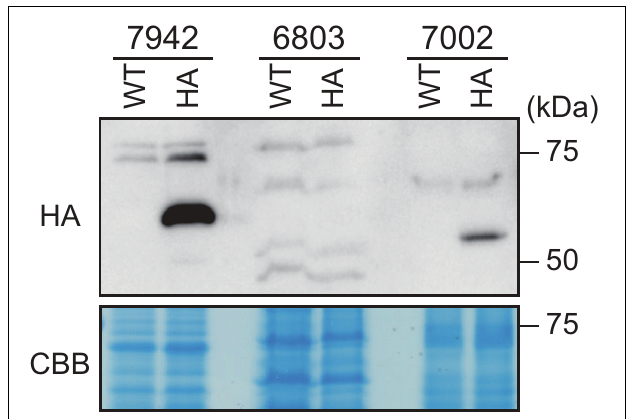
FIGURE 7 | Comparison of DnaA expression levels in Synechococcus elongatus , Synechocystis sp. PCC 6803, and Synechococcus sp. PCC 7002. DNAs encoding HA-tagged DnaA of S . elongatus (7942), Synechocystis sp. PCC 6803 (6803), or Synechococcus sp. PCC 7002 (7002) were integrated into the respective chromosomal dnaA locus (Ohbayashi et al., 2019; Supplementary Figure S3B,C ). HA-DnaA expression was driven by the endogenous dnaA promoter. Exponentially growing transformants were inoculated into fresh inorganic medium and cultured for 6 h with illumination (70 µ mol m - 2 s - 1 ). The same amounts (80 µ g) of proteins extracted from the respective cultures were subjected to immunoblotting using an anti-HA antibody. The respective WTs served as negative controls. CBB-stained protein samples are shown as a loading control.